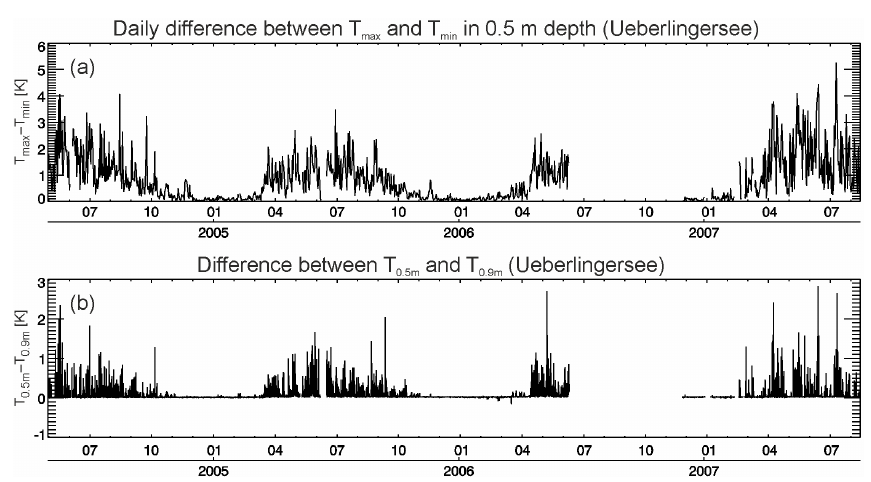
Figure 6. (a) Daily temperature spread ( T max − T min ) at 0.5m water depth at Lake Überlingen and (b) hourly temperature differences between 0.5 and 0.9m water